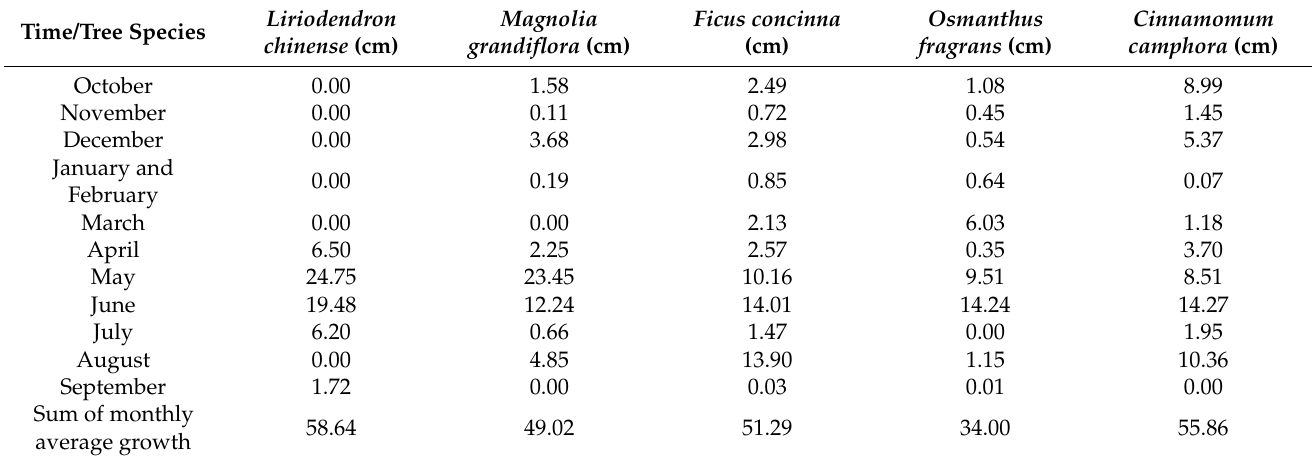
Table 5. The statistics results of the monthly tree height growth of different tree